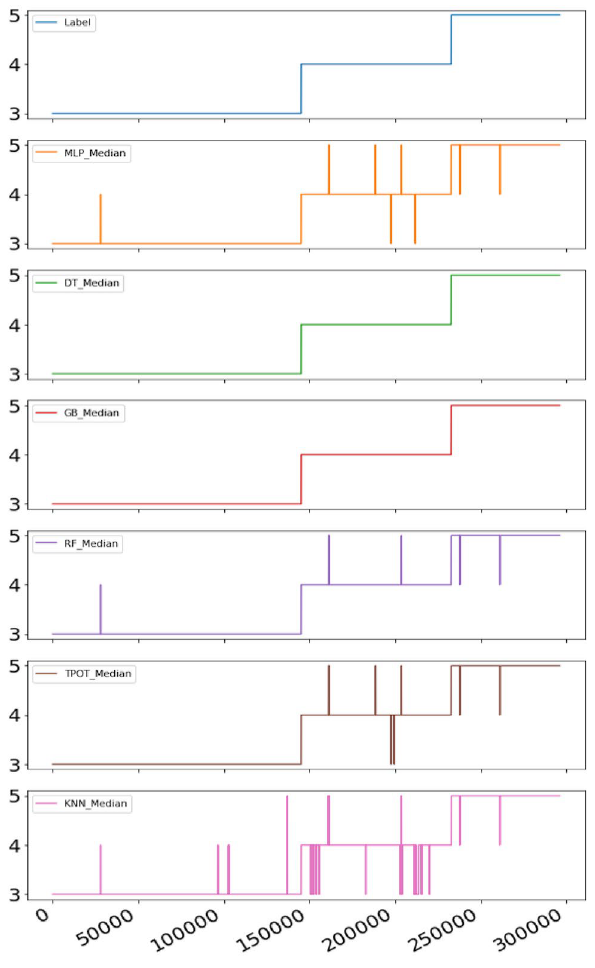
Fig. 8 Prediction from Case 3